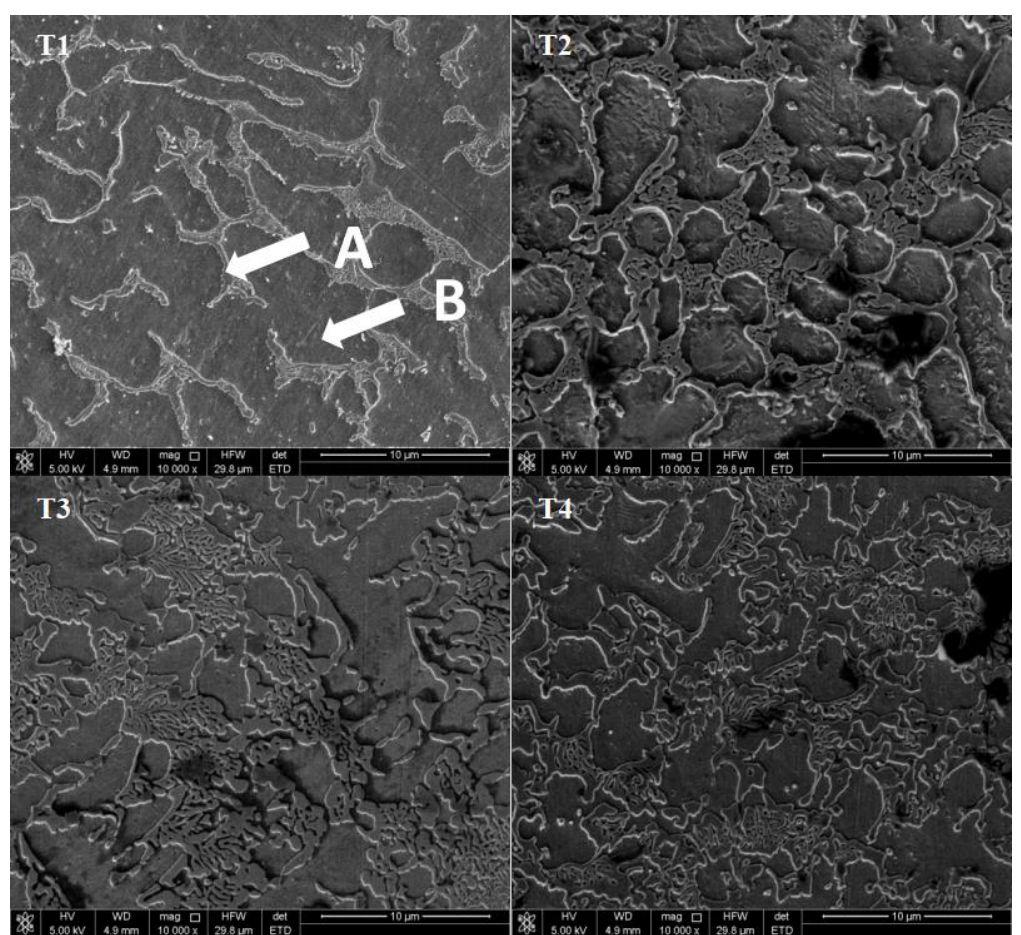
Figure 5. Scanning electron microscopy (SEM) micrographs showing the microstructure of CoCrFeNiTi x HEA laser cladding coatings, where x = 0.1, 0.3, 0.5, or 0.7, and are abbreviated as T1, T2, T3 or T4, respectively.